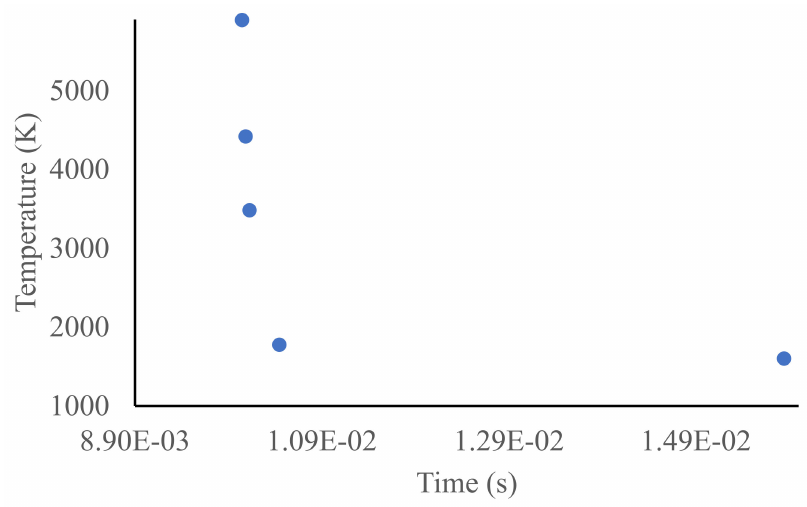
Figure 7. Time at which the temperature of points A, B, C, D and E is at its maximum ( P = 100 W, sp = Y, v = 0.5